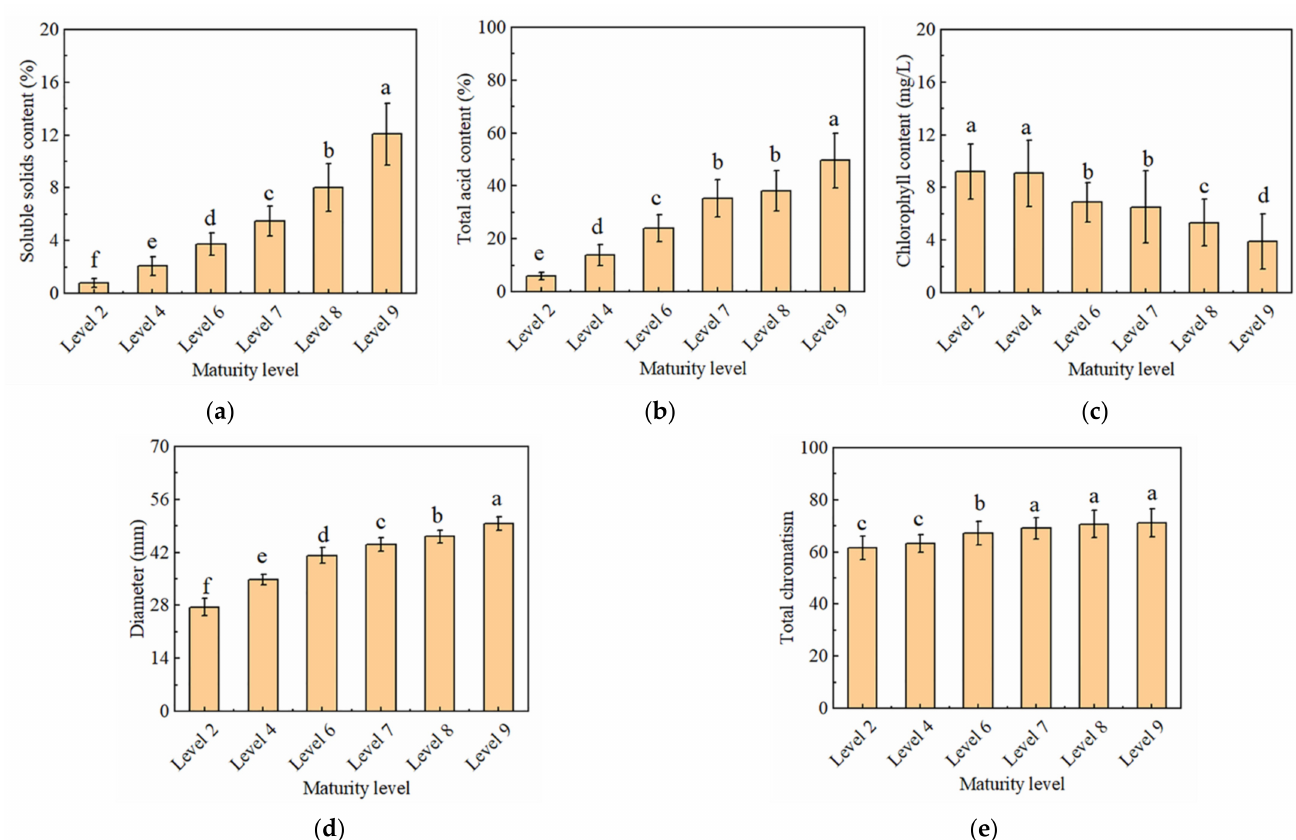
Figure 2. Means with standard deviation of ( a ) SSC; ( b ) TA; ( c ) chlorophyll; ( d ) diameter; and ( e ) total chromatism in banana. Different lowercase letters (a–f) marked on the bars indicate significant differences between different maturity levels at a 0.05